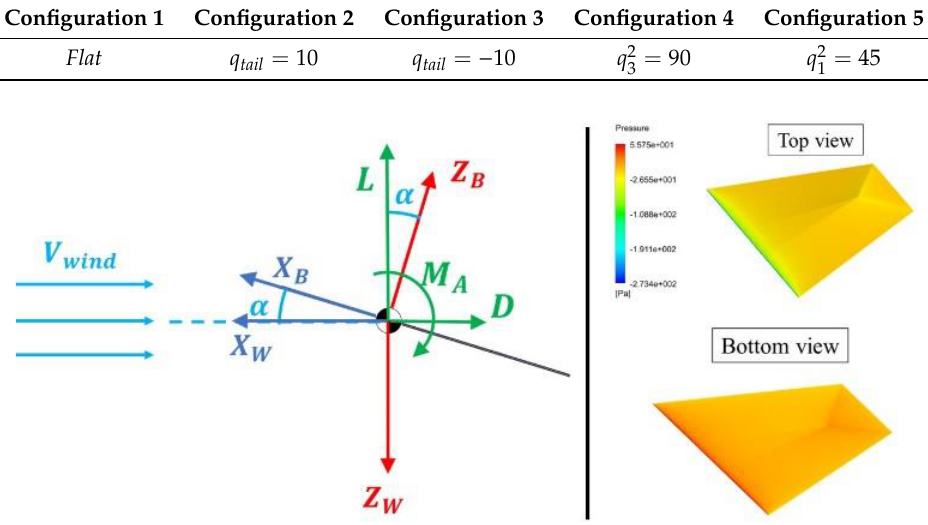
Figure 10. Vectors considered in the computational fluid dynamics (CFD) analysis ( left ): wind velocity, angle of attack, lift and drag, aerodynamic moment, body and wind axes. Pressure distribution in the surface of the winged aerial robot ( right ).